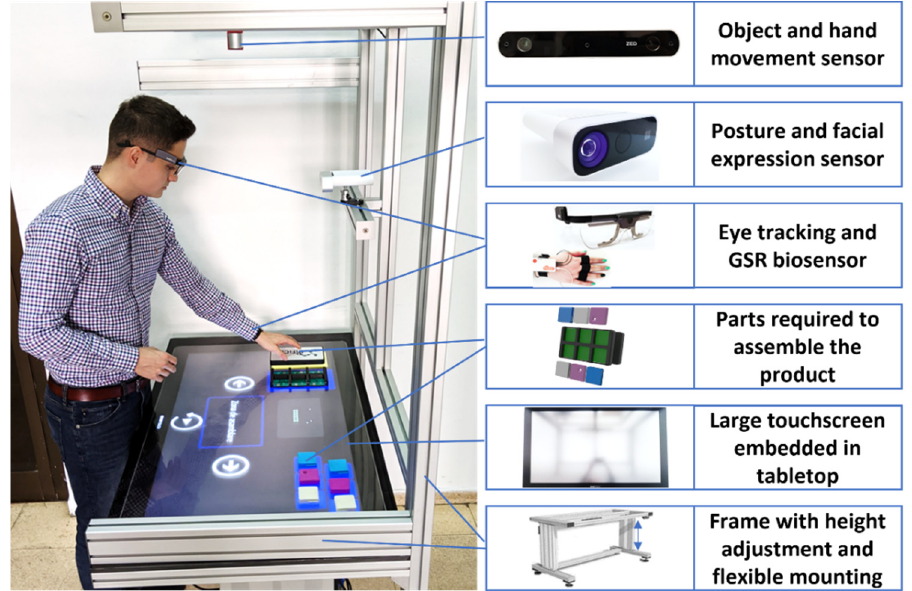
Figure 2. Assembly assistance prototype for manual operations.